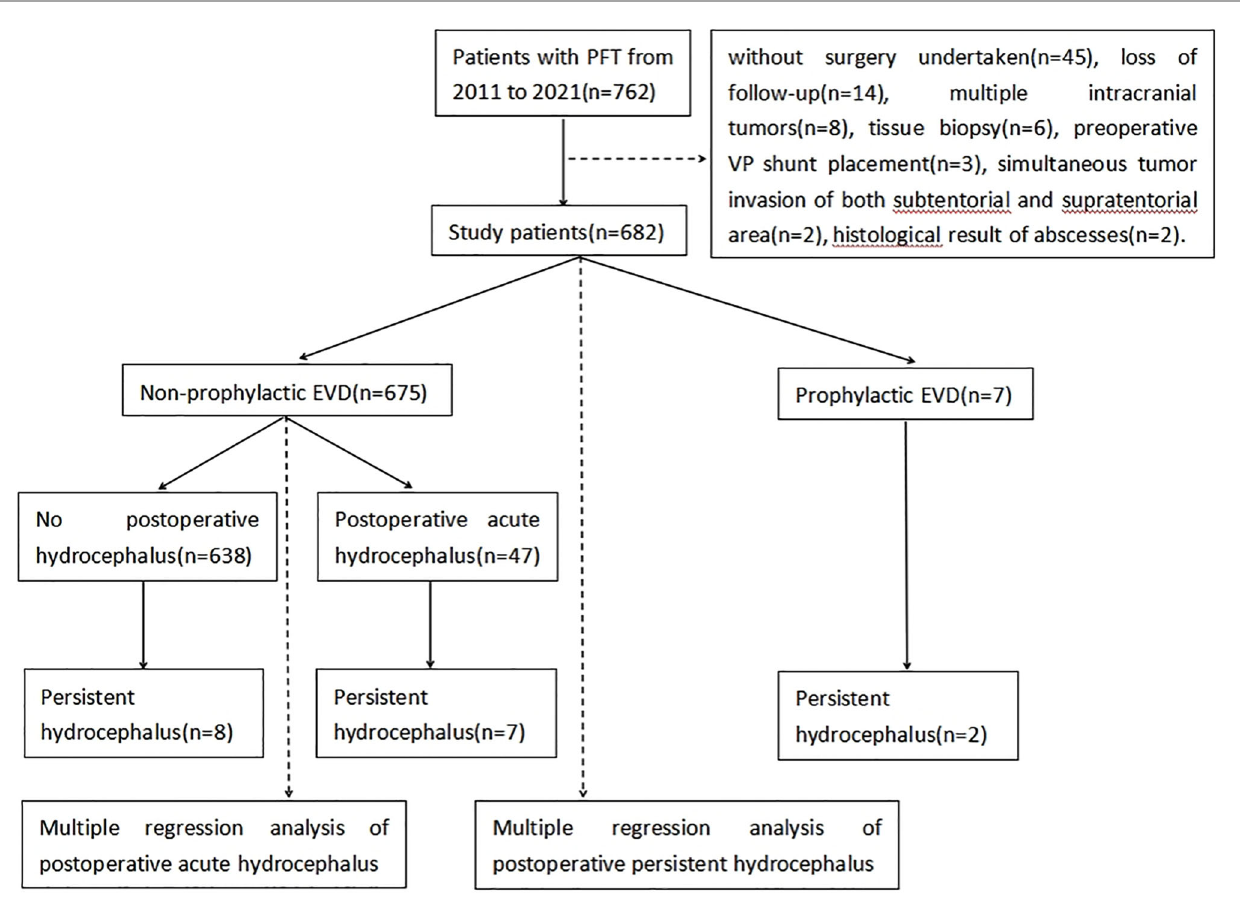
FIGURE 4 | Flow chart for the study population.